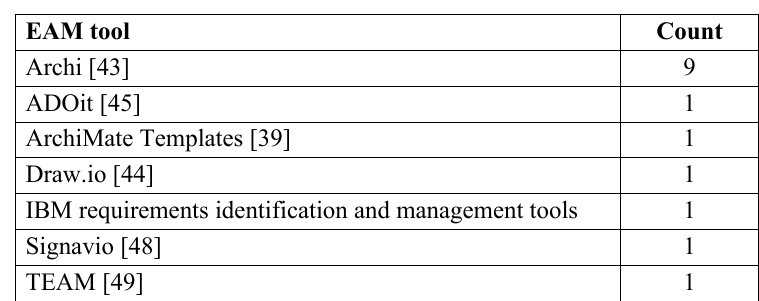
Table 7. Used tools